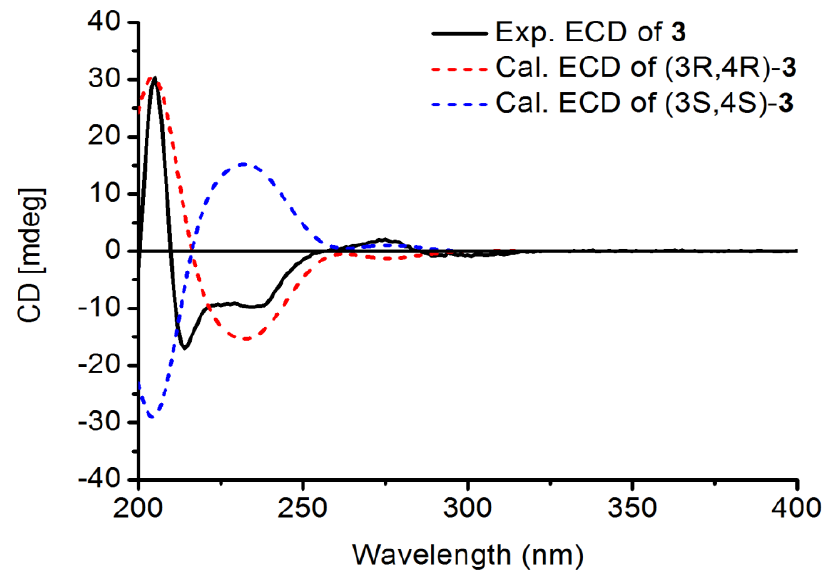
Figure 5. Experimental and calculated ECD spectra of compound 3 .